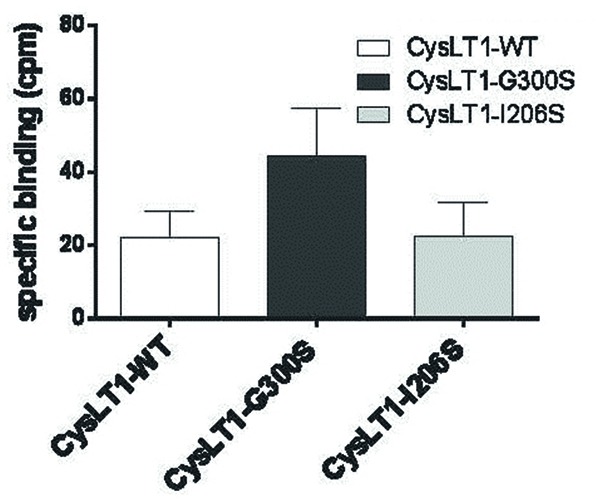
Binding of LTD4 to the CYSLTR1-WT receptor and its variants in transiently transfected HEK293 cells. Forty-eight hours post-transfection, 3H-LTD4 was added to the cells for 1 h, in the presence or absence of non-radioactive LTD4. Following several washes, the radioactivity was measured in a beta-counter (n = 3). Specific binding was calculated by subtracting the non-specific binding (in presence of competition from radioactive LTD4) from the total binding measured (Yaddaden et al., 2016).